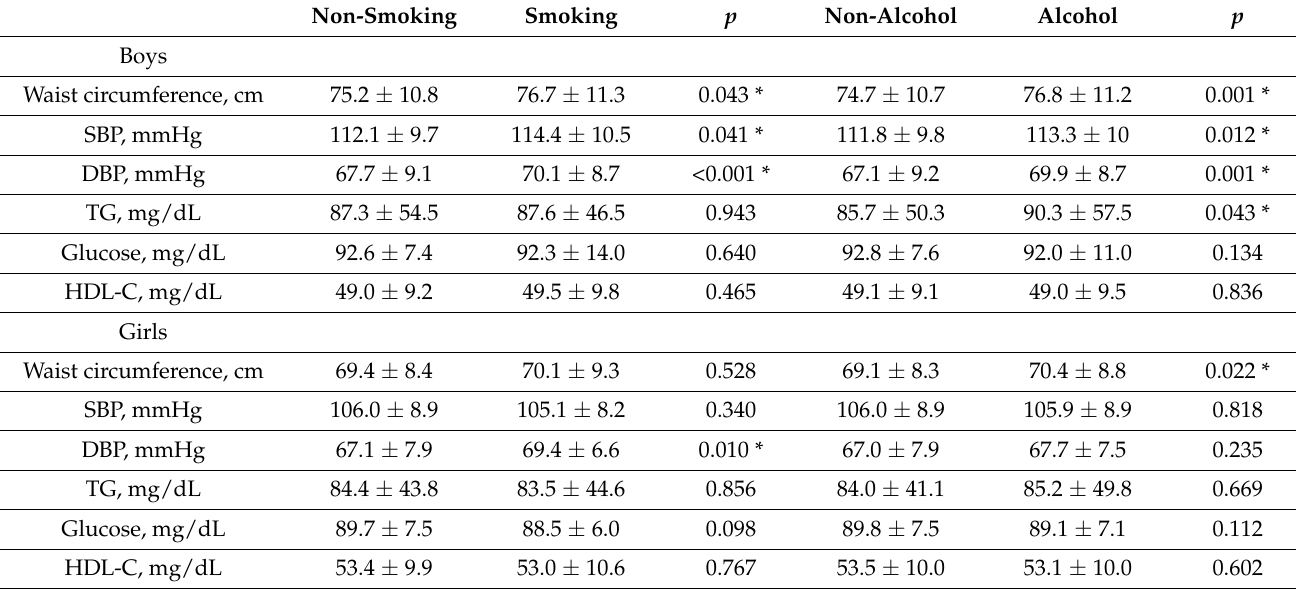
Table 4. Relationship between smoking and alcohol experience and risk metabolic syndrome